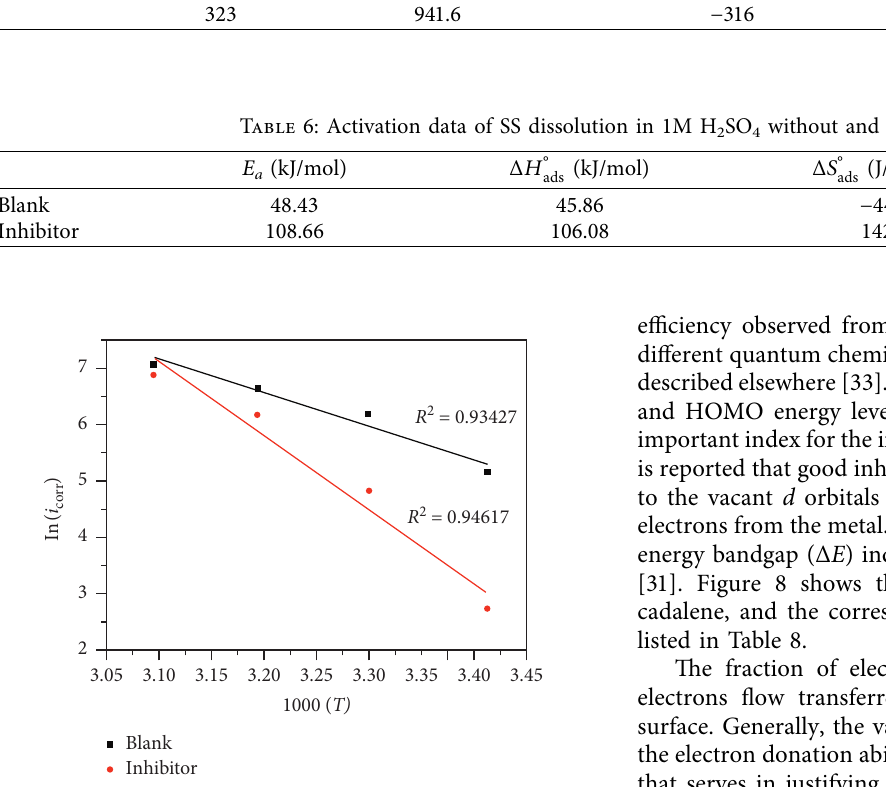
Figure 5: Arrhenius plots for SS in 1M H presence of 10 − 3 M of ACM.